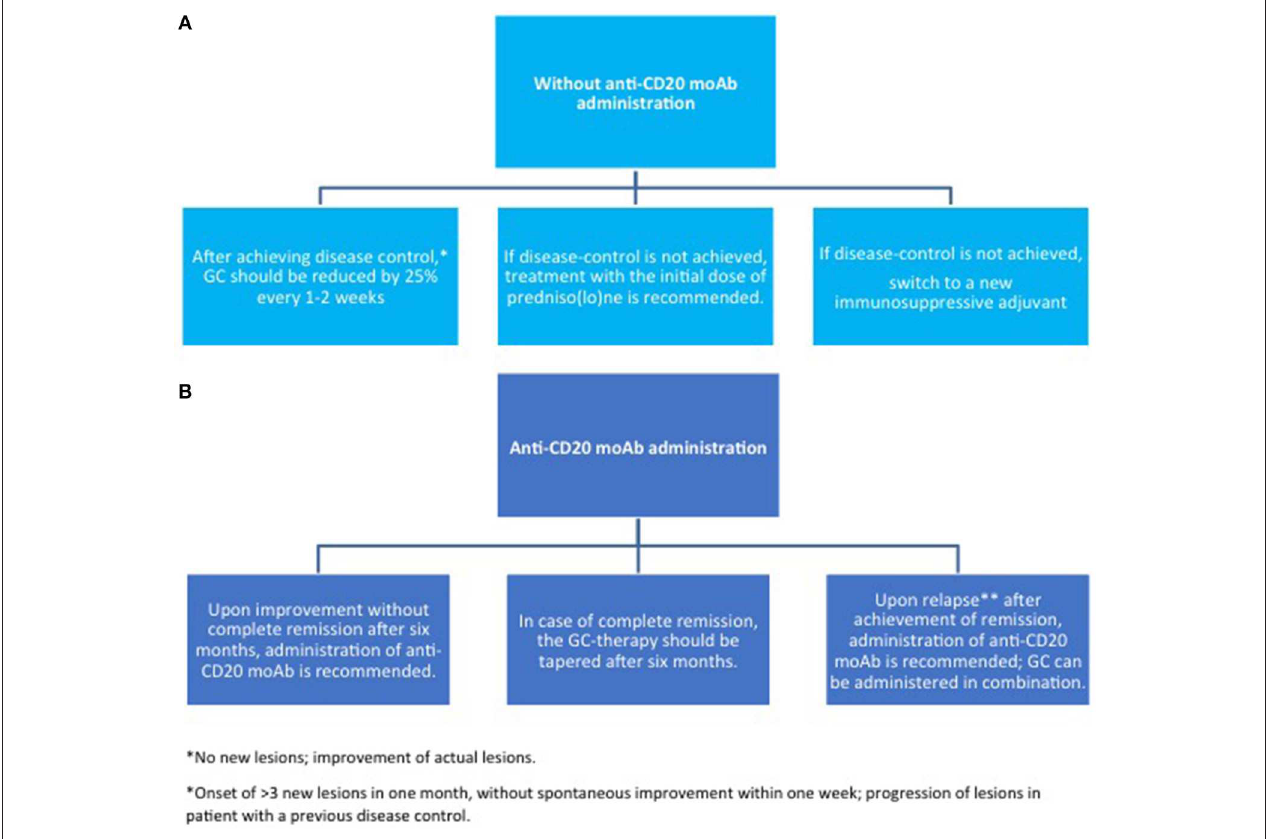
FIGURE 6 | Maintenance therapy in pemphigus. (A) without anti-CD20 moAb; (B) with anti-CD20 moAb. GC, glucocorticoids; moAb, monoclonal